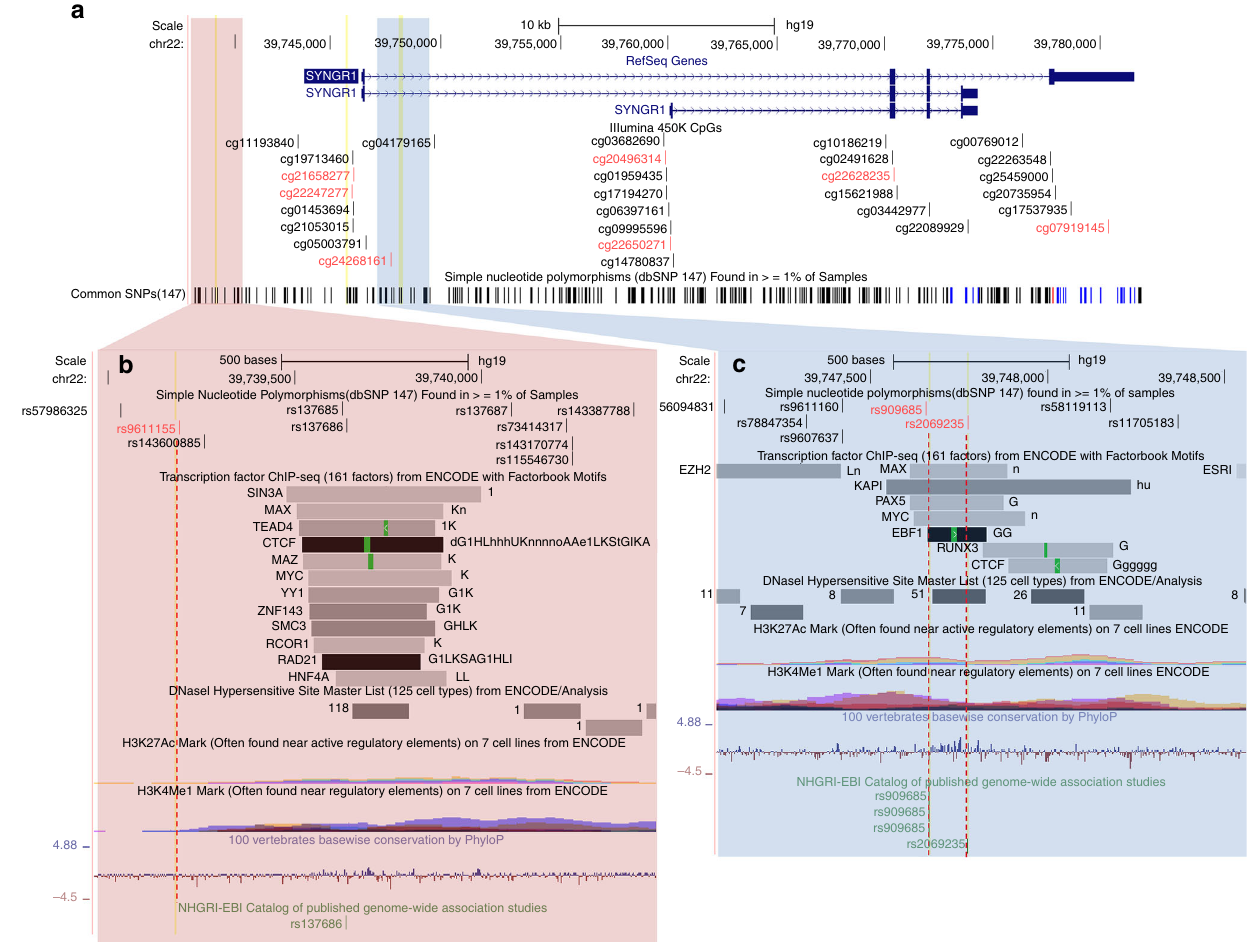
Fig. 8 Overlap with genomic annotations for three candidate causal SNPs for an eQTL that co-localizes with seven meQTLs and shows strong evidence of mediation. a The SYNGR1 gene region has seven CpG sites (in red) affected by a common causal variant. Possible causal variants include rs9611155 ( b )